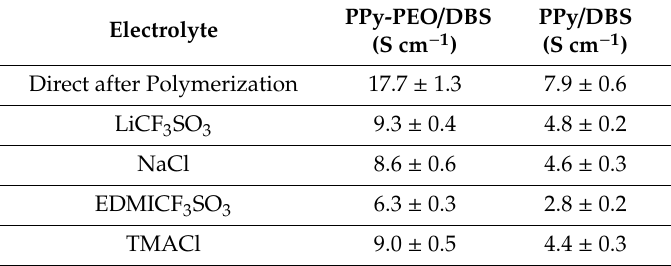
Table 1. Conductivity of PPy-PEO / DBS and PPy / DBS after polymerization (oxidized state) and after actuation (oxidized state) in aqueous electrolytes of LiCF 3 SO 3 , NaCl, EDMICF 3 SO 3 and TMACl.